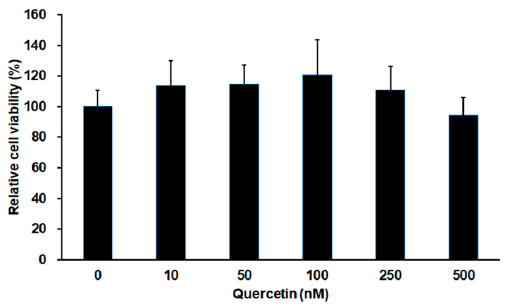
Figure 1. Effect of quercetin on cell viability in 661W cells. Cell viability was evaluated by MTS assay. The cells were incubated with different concentration of quercetin for 24 h. No significant difference between treatments. Data are the means ± SDs of six independent experiments.